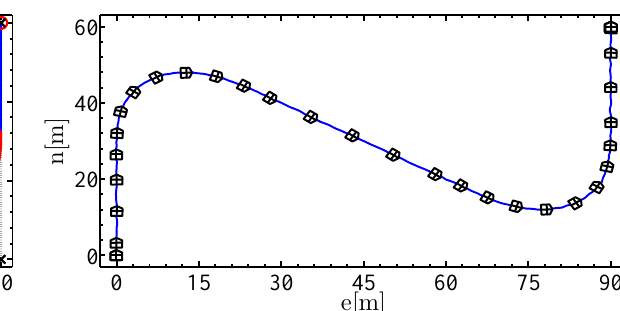
Figure 14: Trajectory described by the ROV in the NE- plane. The patches indicate the heading.